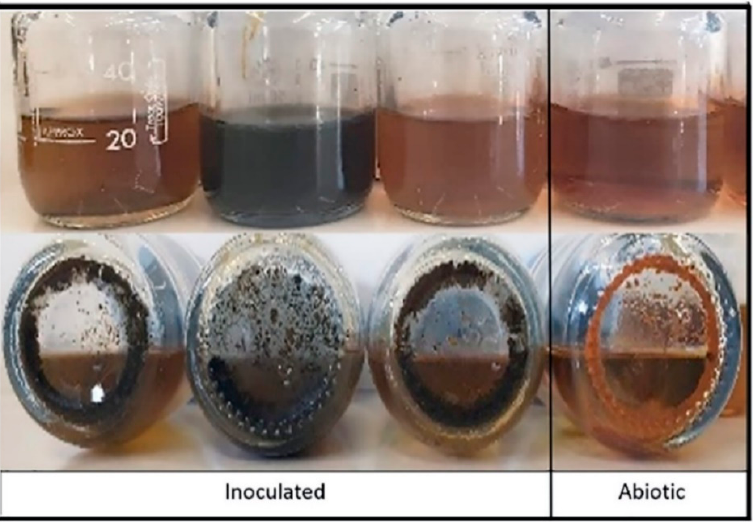
Figure 5. Left: Image of sodium thioglycolate (500 mg/L; THIO2) solutions 3 weeks after inoculation and in abiotic control.